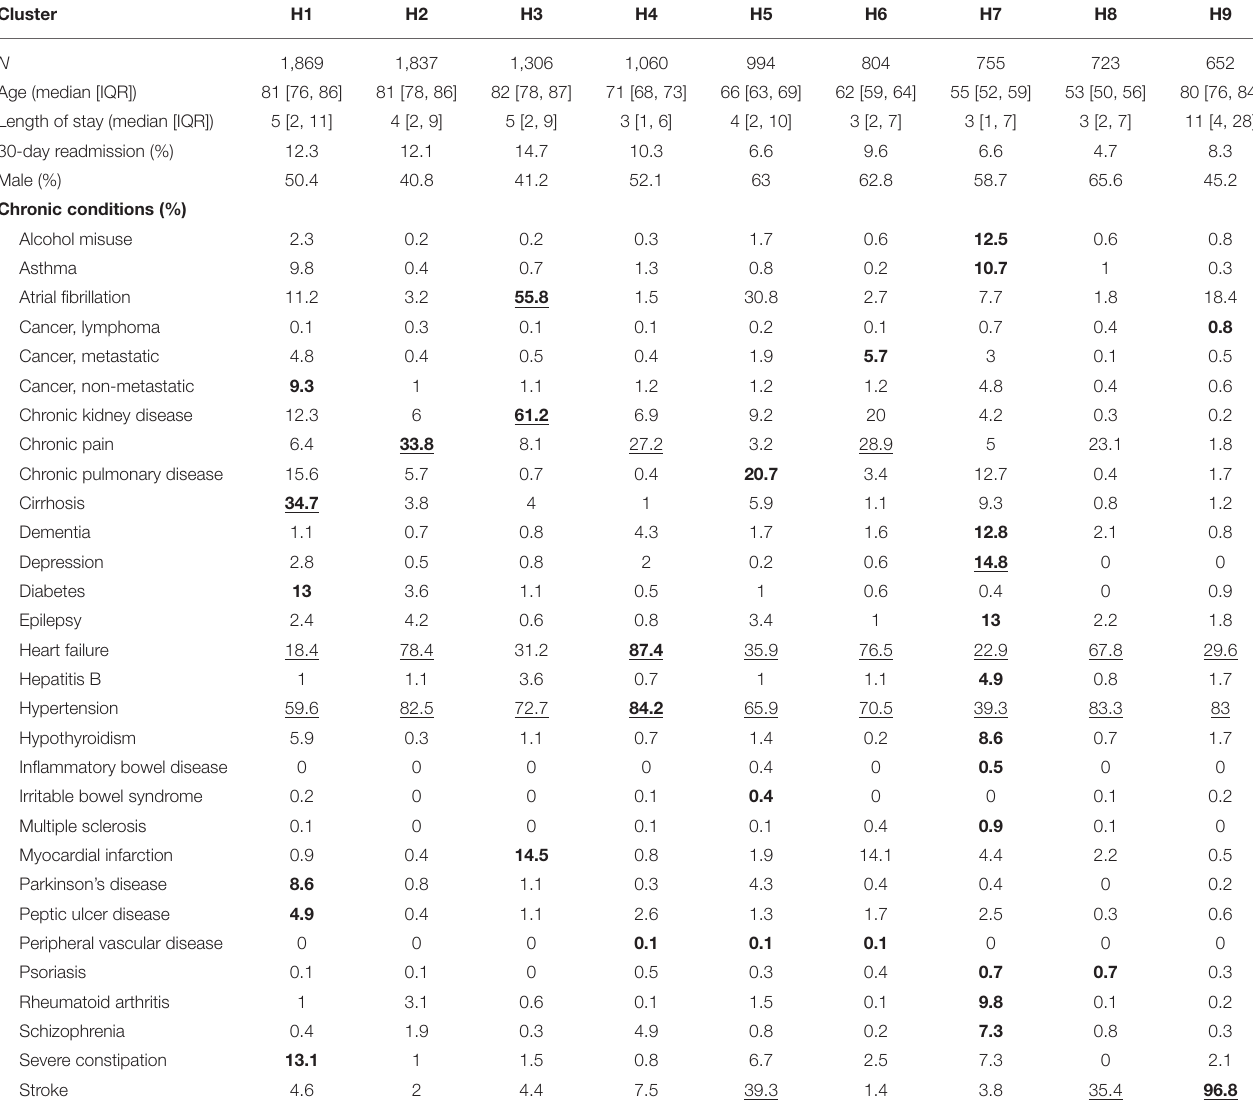
TABLE 2 | Prevalence of chronic conditions by cluster (Hong Kong)*. Cluster